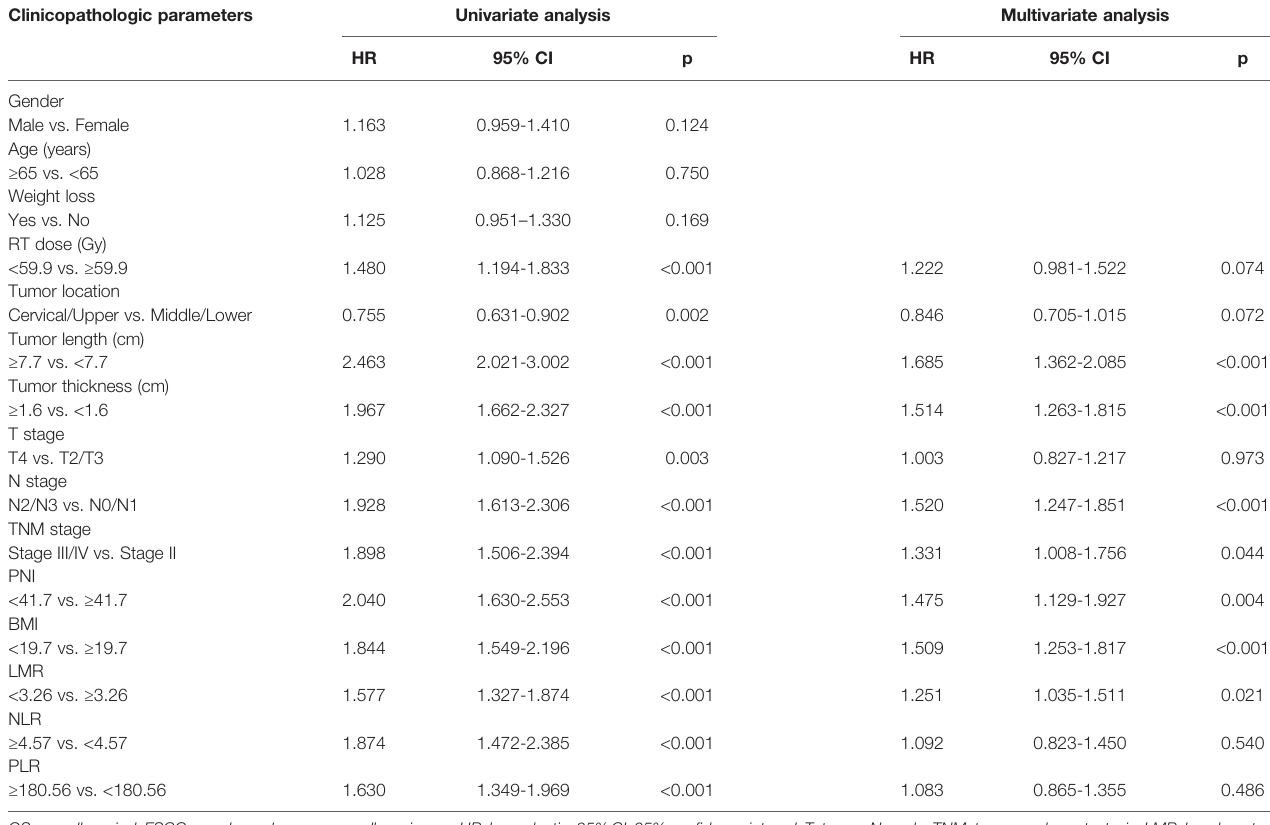
TABLE 2 | Univariate and multivariate analyses of prognostic factors for OS in patients with